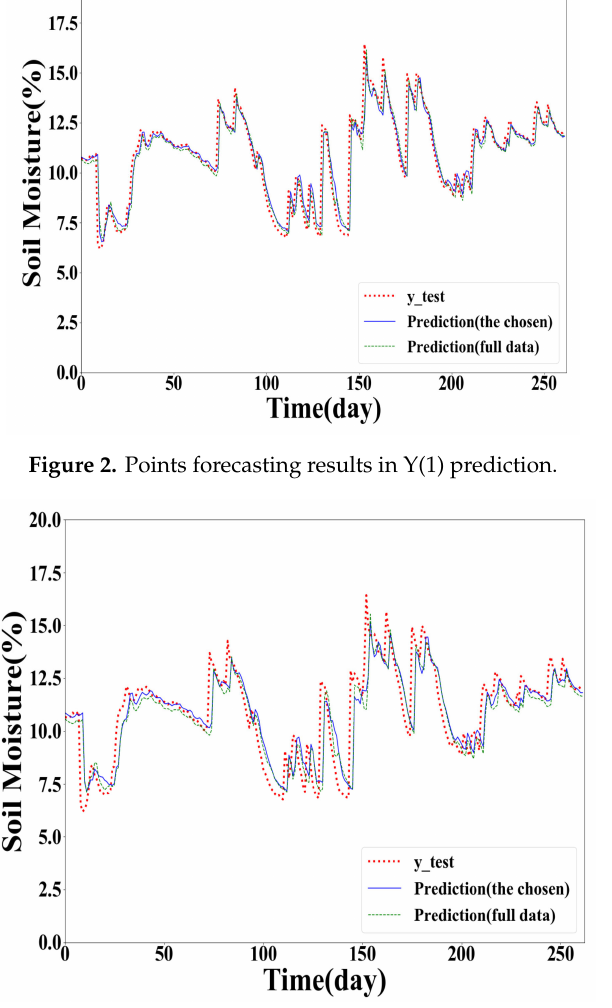
Figure 3. Points forecasting results in Y(2)